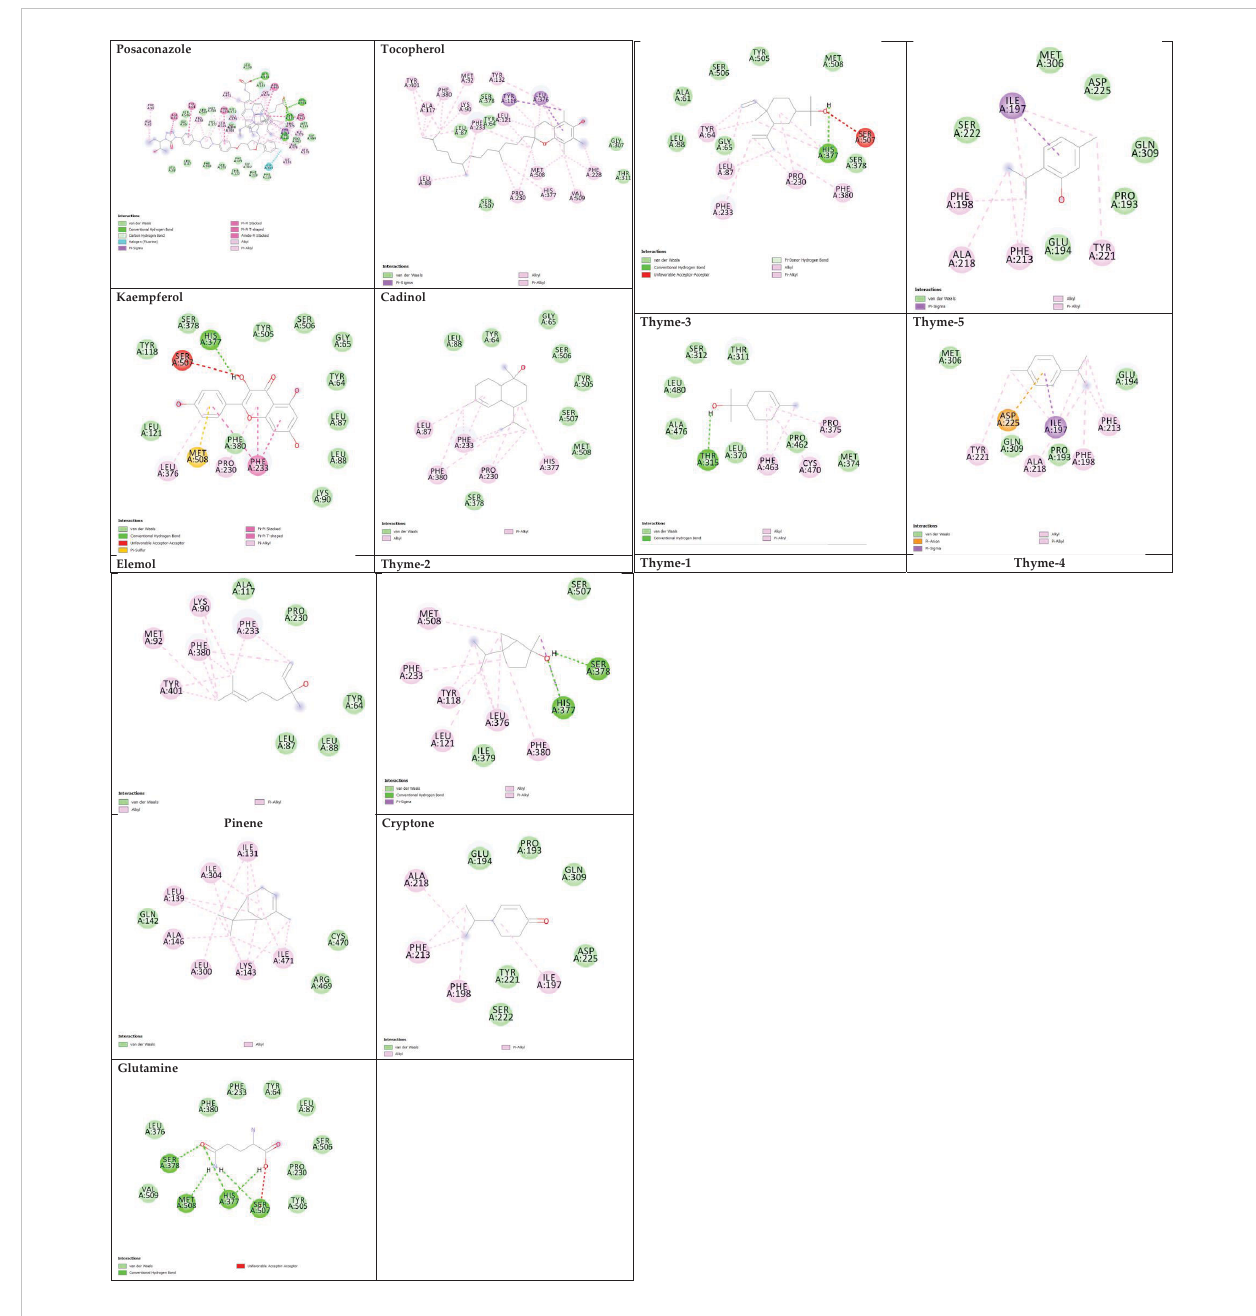
FIGURE 8 2D ligand interaction diagram of the proposed molecules with sterol 14-alpha demethylase.